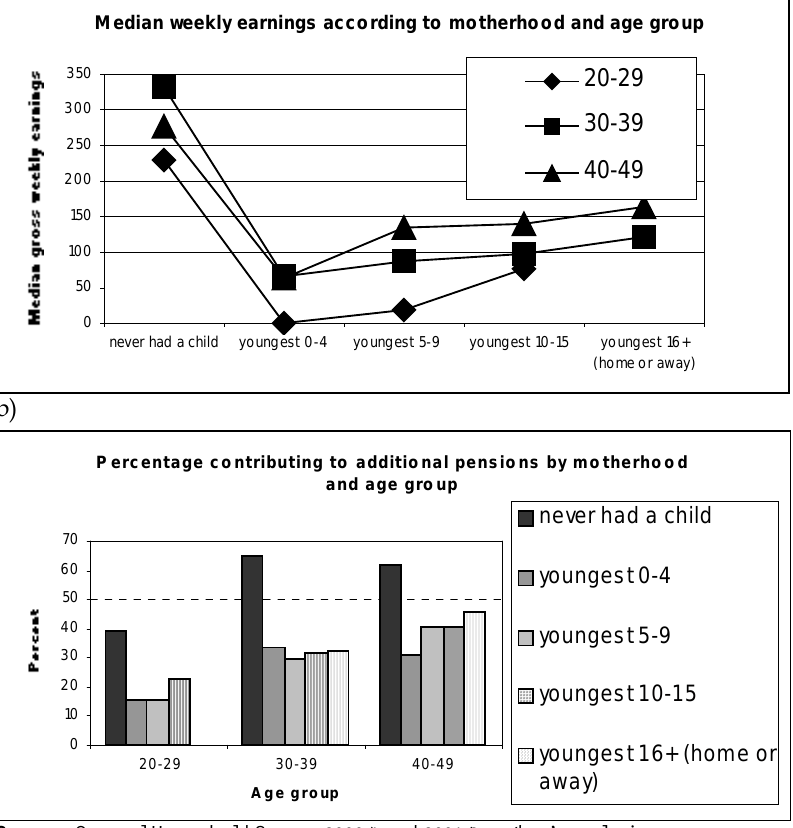
Figure 4: Median weekly earnings and percentage of women making